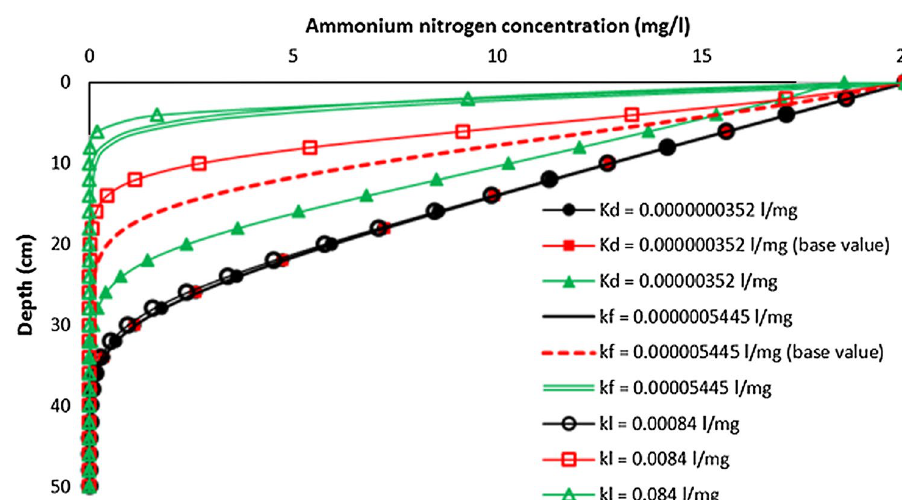
Fig. 7 Sensitivity analysis of linear, Freundlich and Lang- muir isotherm coefficients for ammonium nitrogen concentra- tion (refer to Tables 2 and 3 for other data)